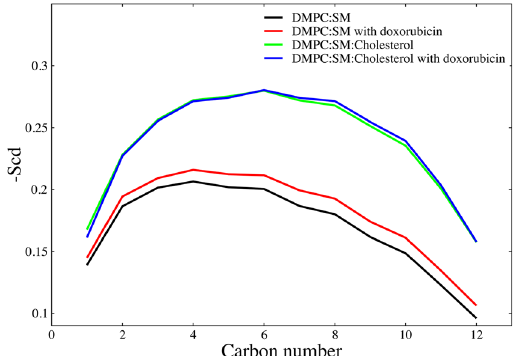
Figure 7. Order parameter of the sn -2 chain of DMPC molecule. Order parameter shows that the increase in lipid order parameter in DMPC:SM membrane is more pronounced as compared to DMPC:SM:Chol membrane in presence of doxorubicin molecule.